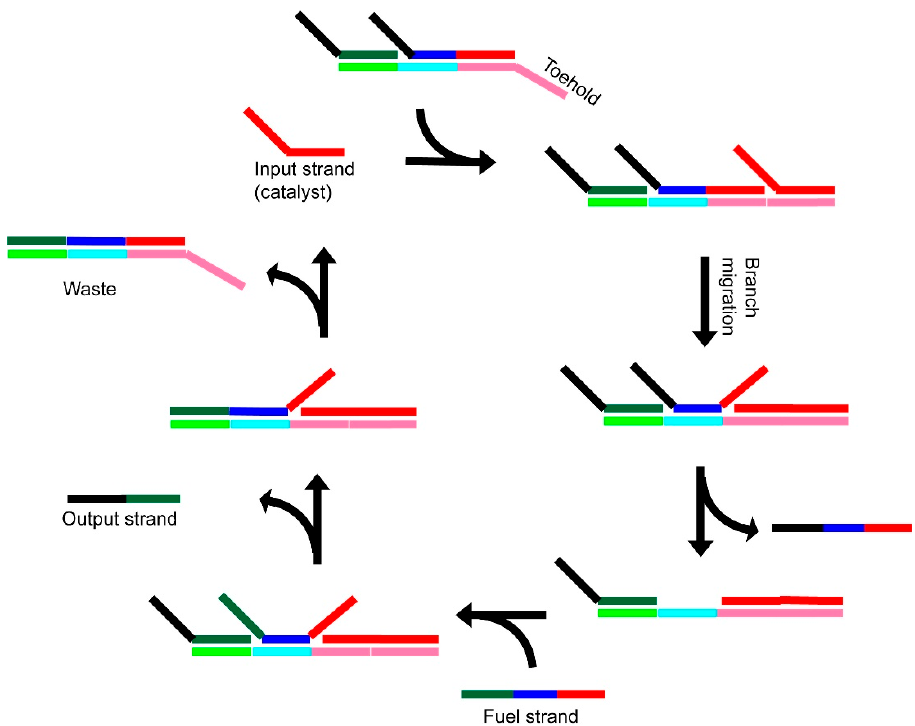
Figure 7. Schematic of toehold-mediated strand displacement using a seesaw gate. Different DNA sequences are shown in different colors, with black representing regions that do not form base pairs. Shades of the same color represent complementary sequences. First, the input strand hybridizes with the toehold (pink). The input strand further hybridizes to the gate via branch migration and displaces the initial complementary strand (black-blue-red). The fuel strand displaces both the output strand and input strand. The input strand can then continue the cycle with another molecule of gate DNA. The output strand can act as an input strand for a different gate.